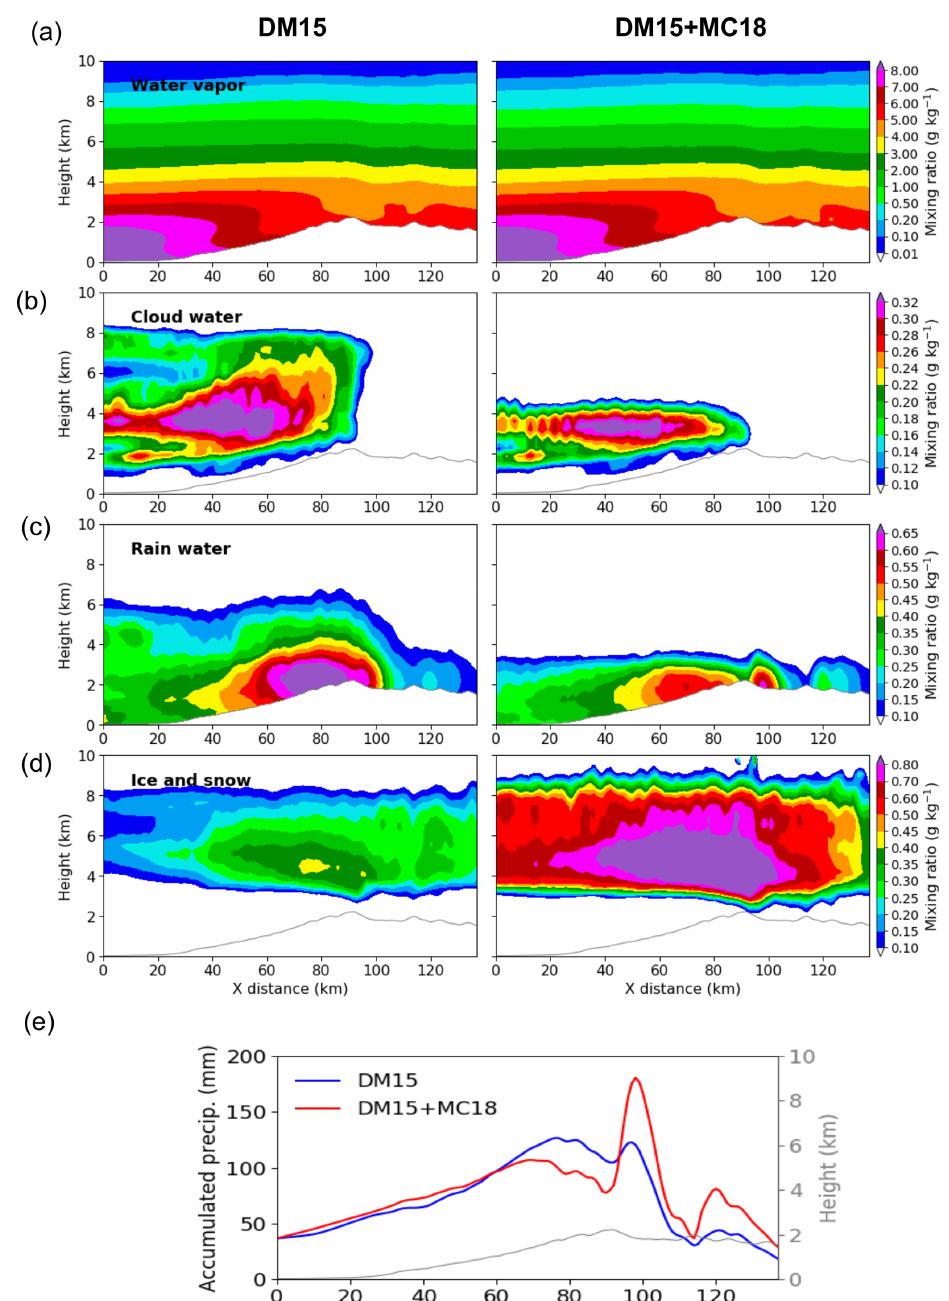
Figure 9. Mean mixing ratios of (a) water vapor, (b) cloud water, (c) rainwater, (d) ice + snow, and (e) surface precipitation at the stage after AR landfall in DM15 and DM15 + MC18. The vertical cross sections are averaged over the red boxes marked in Fig. 8b and the entire stage.